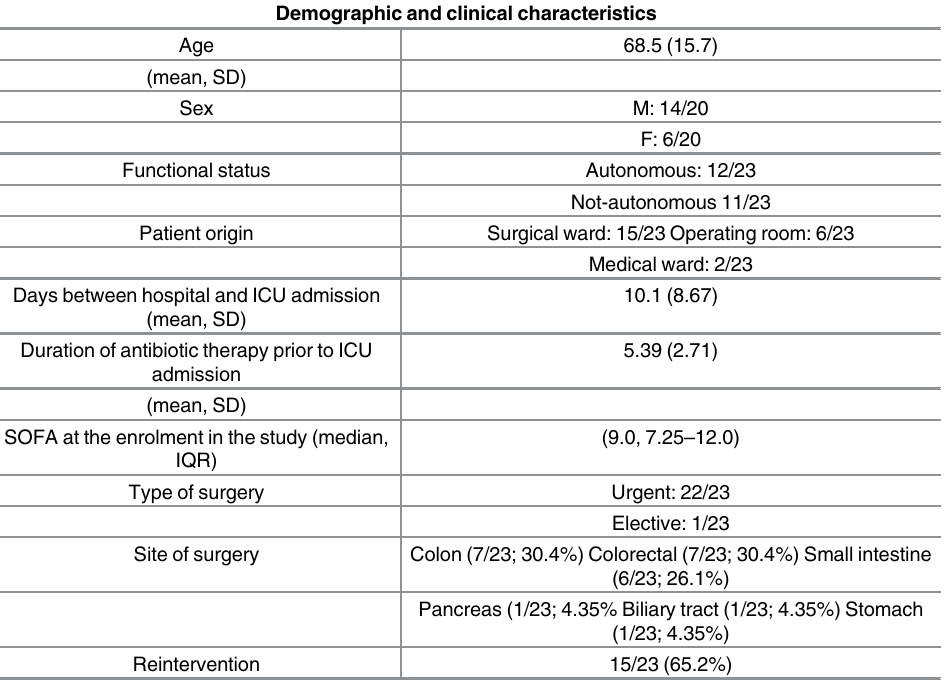
Table 1. Demographic and clinical characteristics of patients included in the